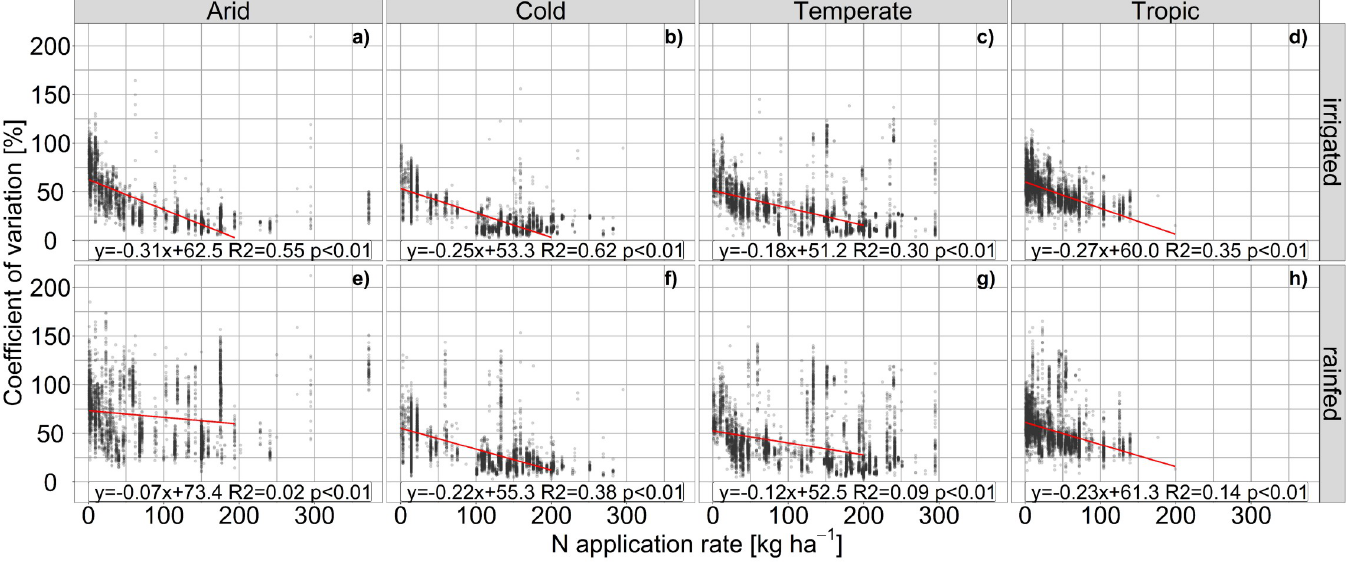
Fig 5. Coefficient of variation for maize yields among EPIC-based GGCMs compared to fertilizer application rates. Results are shown for the fully harmonized management scenario (fullharm) with sufficiently irrigated (a-d) or rainfed (e-h) water supply in each grid cell of four major climate regions. Linear regressions are limited to � 200 kg N ha -1 , which commonly corresponds to sufficient N supply